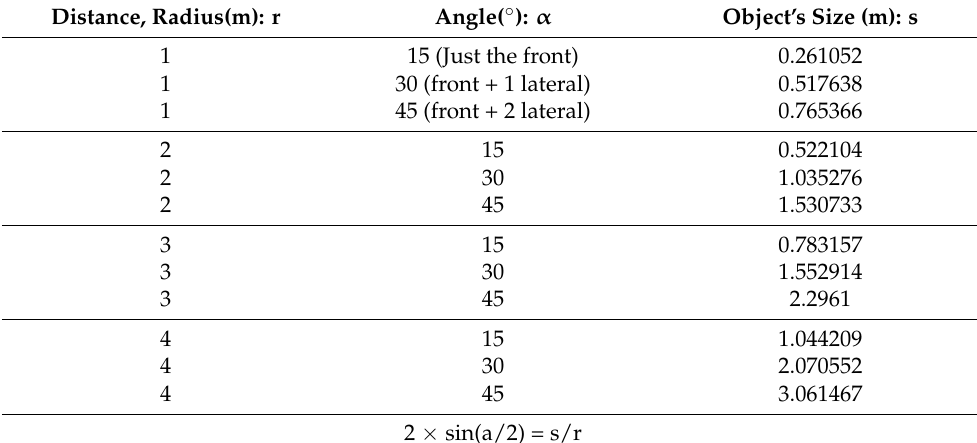
Table 1. Object size for different distances and